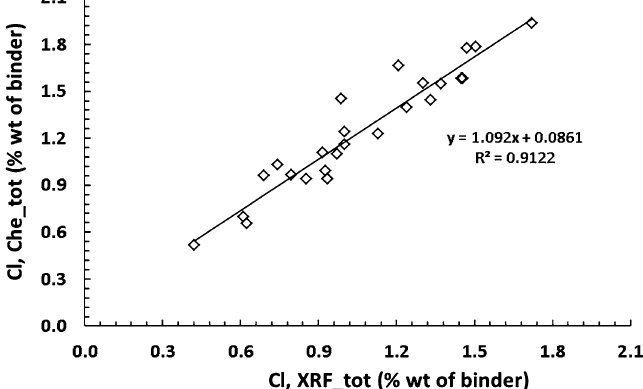
Fig. 13 Relationships between XRF and chemical analysis of total chloride